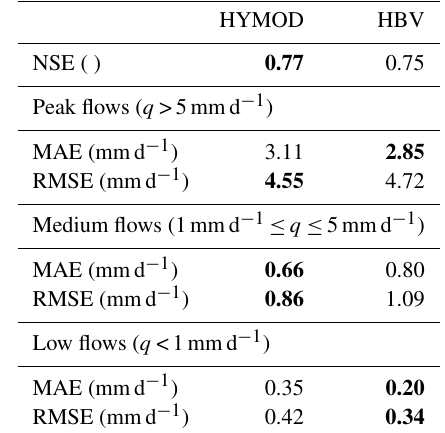
Table 2. Model performance in pre-change conditions used for cal- ibration (1975–1979). Boldface numbers correspond to the model with superior performance for the particular metric. NSE is the Nash–Sutcliffe efficiency; MAE is the mean absolute error; RMSE is the root mean squared